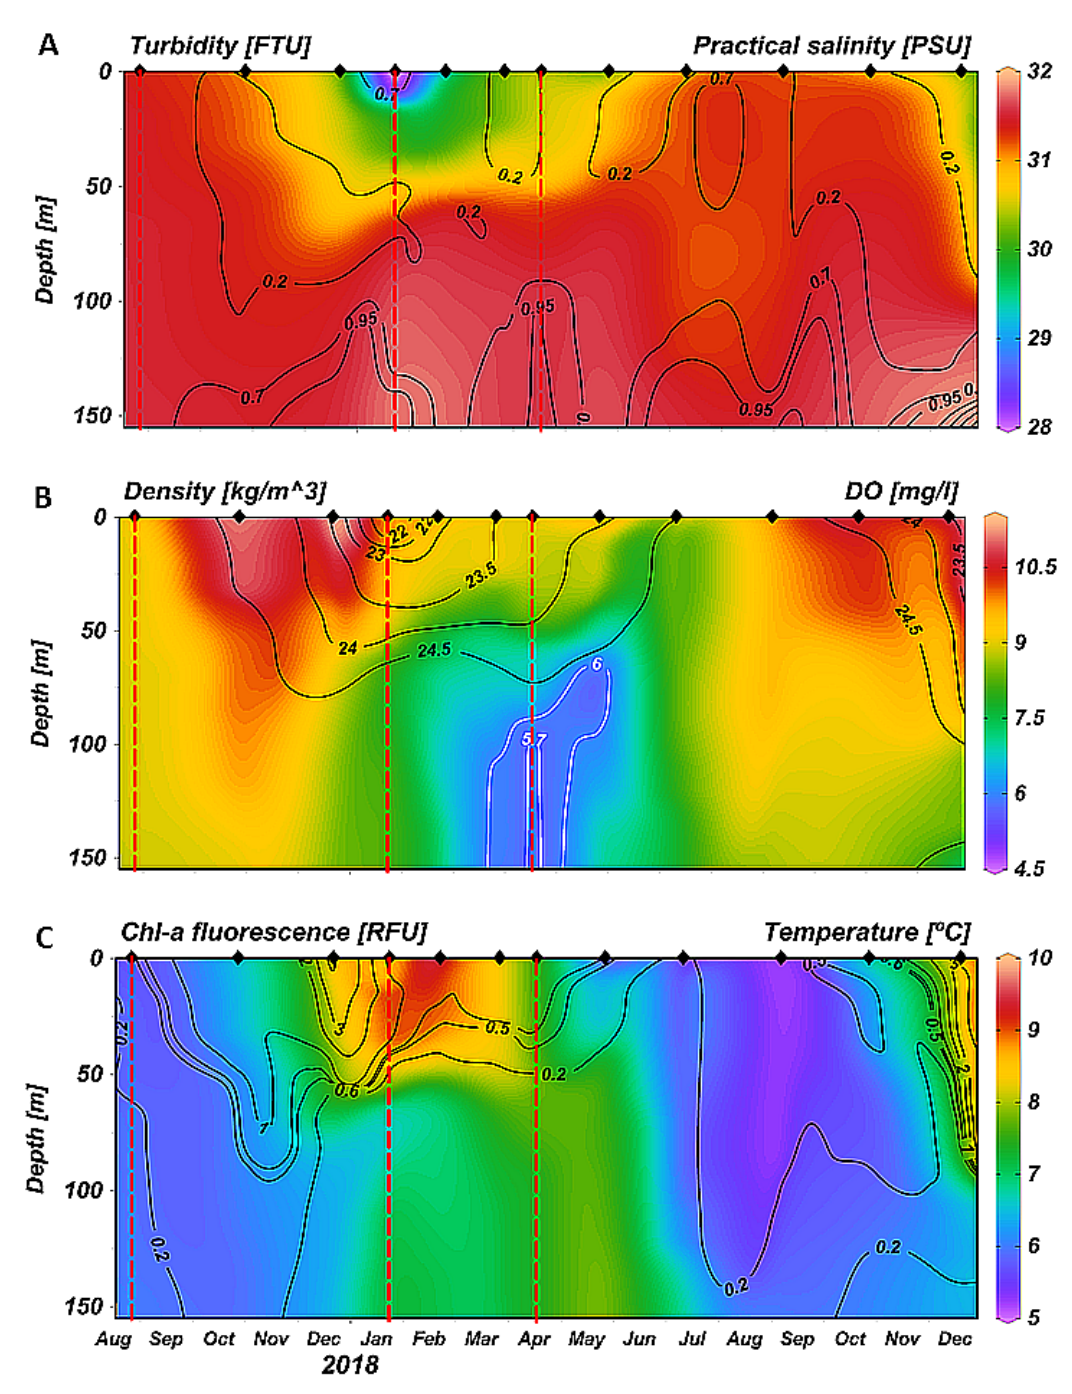
Figure 2. Time series at the fixed station over the entire water column measured between August 2017 and December 2018 of ( A ) salinity (in gradient color) and turbidity (black isolines); ( B ) dissolved oxygen (in gradient color and white isolines) and density anomaly (black isolines); and ( C ) temperature (in gradient color) and Chl-a fluorescence (black isolines). The enhanced observation period: red dotted lines are the field trips of August 2017, January 2018, and April 2018.